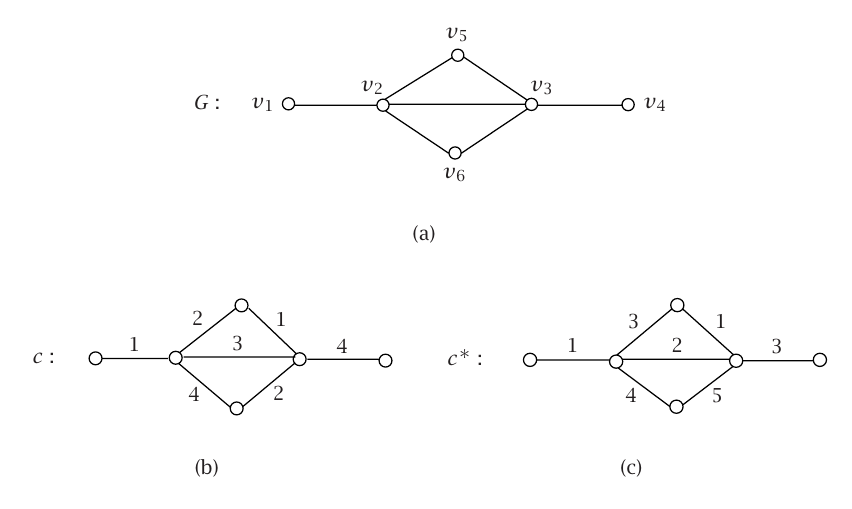
= 3, χ = 4, and χ e (G) d (G)